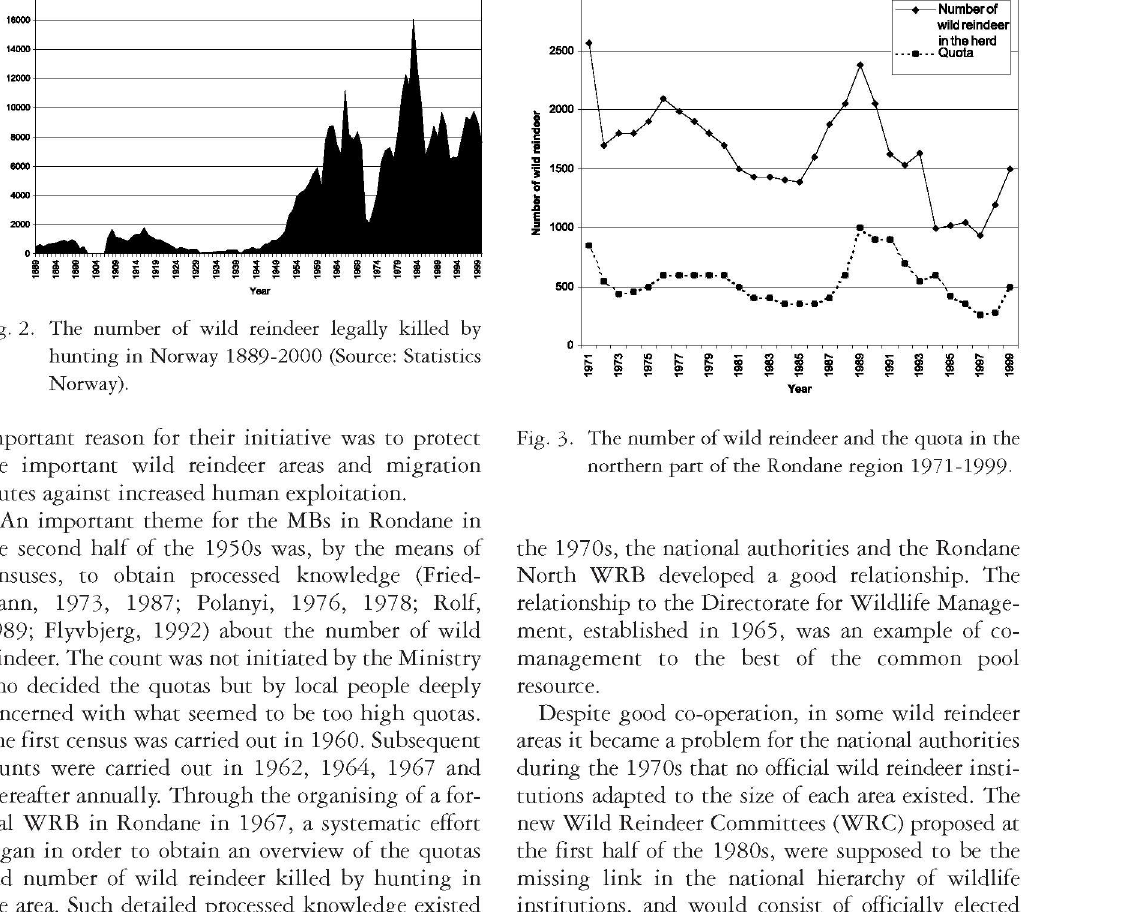
Fig. 2. The number of wild reindeer legally killed by hunting in Norway 1889-2000 (Source: Statistics Norway).